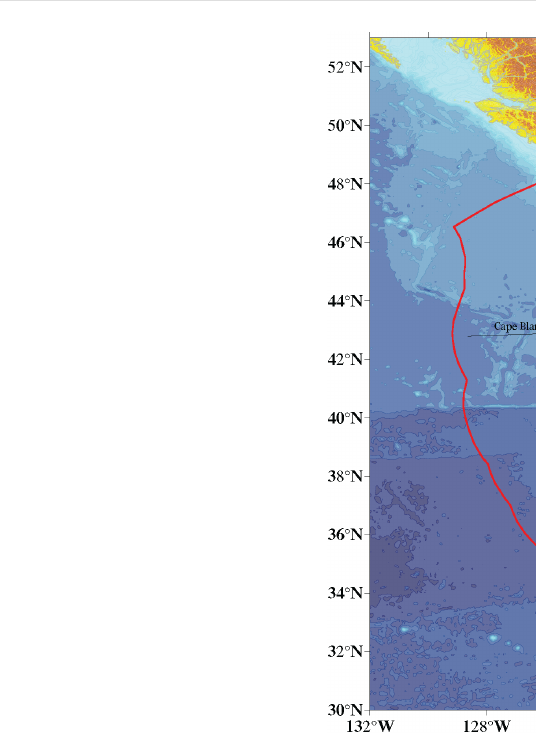
FIGURE 1 California Current Large Marine Ecosystem (CCLME). This study assessed species within U.S. borders